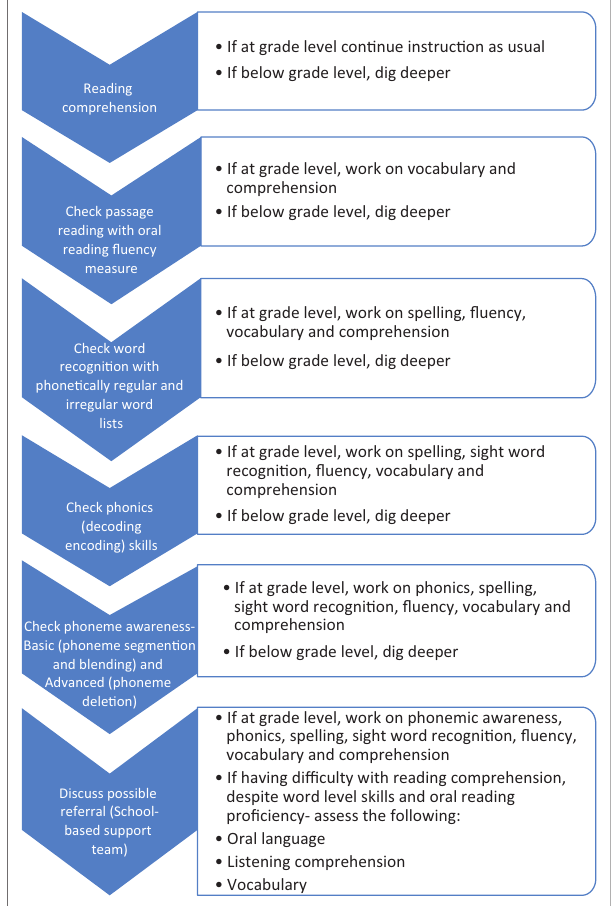
FIGURE 1: Digging to diagnose target areas of